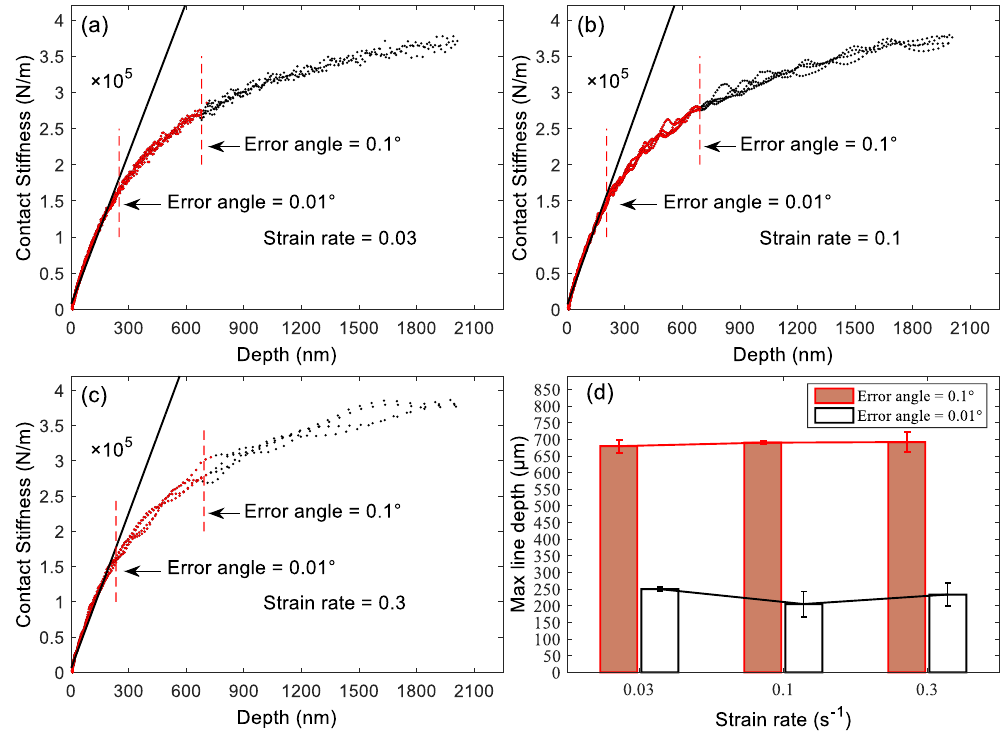
Figure 6. The contact stiffness vs. depth curves under three strain rates: ( a ) 0.03 s −1 ; ( b ) 0.1 s −1 ; ( c ) 0.3 s −1 ; ( d ) Figure6. Thecontactsti ff nessvs. depthcurvesunderthreestrainrates: ( a )0.03s − 1 ; ( b )0.1s − 1 ; ( c ) 0.3 s − 1 ; the maximum depth of the straight-line segment in contact with the stiffness-–depth curves. ( d ) the maximum depth of the straight-line segment in contact with the sti ff ness—depth curves. The straight-line segments of these contact sti ff ness versus depth curves near the origin point can The straight-line segments of these contact stiffness versus depth curves near the origin point can ◦ ◦ be extracted by a Hough transform with error angles of 0.01 and 0.1 , as shown in Figure 6a − c. The be extracted by a Hough transform with error angles of 0.01° and 0.1°, as shown in Figure 6a−c. The maximum depth of the straight-line segments under di ff erent error angles are shown in Figure 6d. This maximum depth of the straight-line segments under different error angles are shown in Figure 6d. result indicates that there is no significant di ff erence in the maximum depth of the straight-line segment under the three strain rates, so the indentation depth influenced by the residual compressive stress is independent of the strain rate. According to the previous analysis, we propose that the residual compressive stress has no influence on the elastic modulus and hardness at a depth of ~250 nm and only a slight influence at a depth of ~650 nm, as shown in Figure